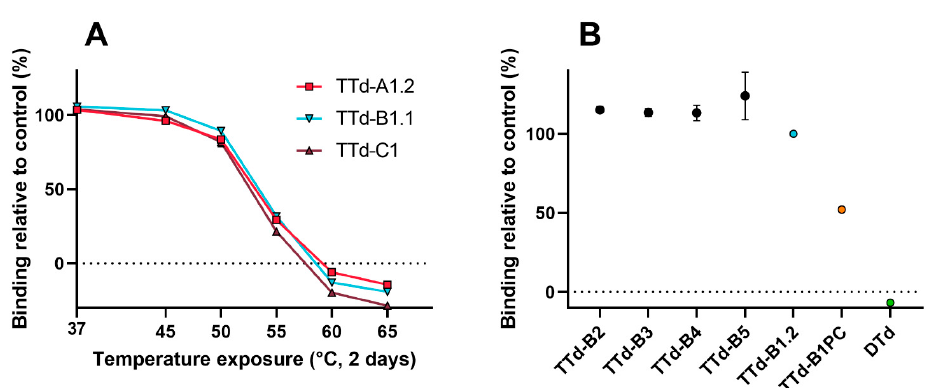
Figure 5. Biosensor analysis of tetanus toxoids. ( A ) Decrease in antibody binding relative to the 4 °C control. ( B ) Comparison of antibody binding between the various batches relative to TTd-B1.2. Error bars represent the SD of three aliquots of the same batch.